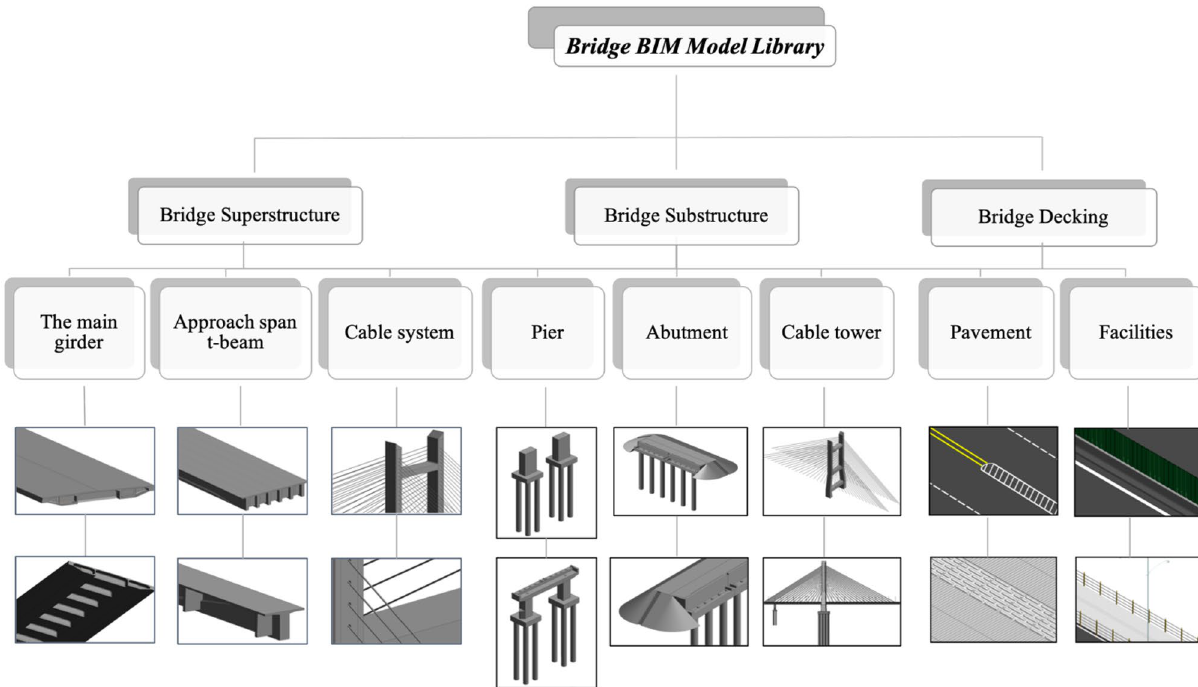
Figure 9. Classifications of the Cocodala Bridge BIM model library.